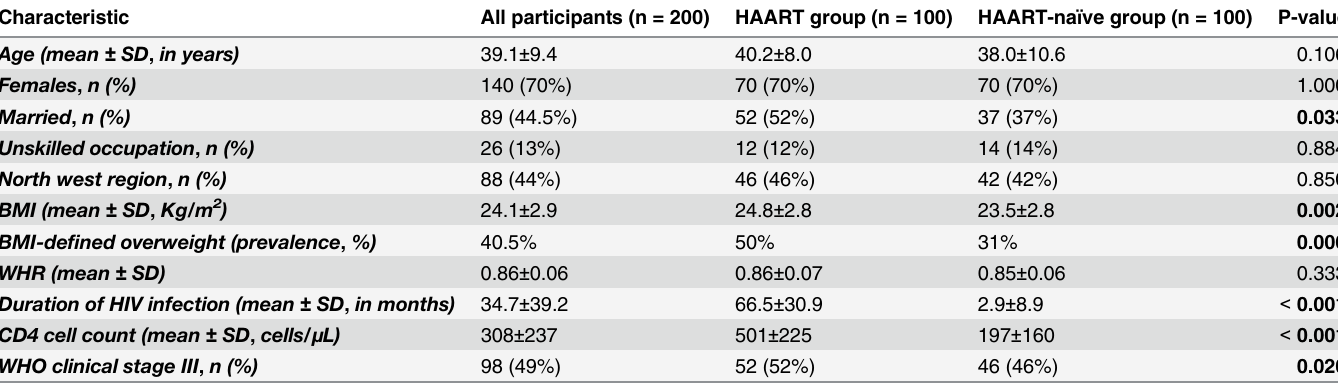
Table 1. Socio-demographic and clinical characteristics of the participants.